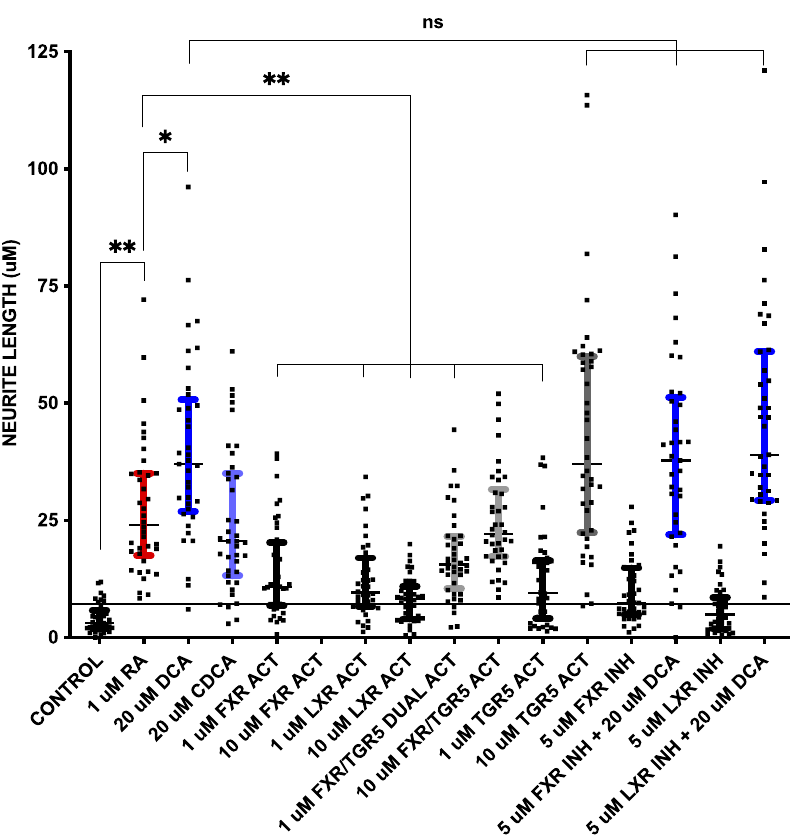
Figure 3. Neurite outgrowth measured as neurite length, as described in Figure 1, from cells in Fig- ure 2. The horizontal line at ~8 μm is drawn through + 1 standard deviation of control neurite length measurements. The conditions in which 1 standard deviation did not overlap with control (i.e., above horizontal line) are colored: 1 μM RA in red, 20 μM DCA in dark blue, 20 μM CDCA in light blue, 1 μM INT 747 (FXR/TGR5 dual activator) in light gray, 10 μM INT 747 (FXR/TGR5 dual acti- vator) in light gray, 10 μM RG-239 (TGR5 activator) in dark gray, 5 μM Z-Guggulsterone (FXR in- hibitor) + 20 μM DCA in dark blue and 5 μM GSK 2033 (LXR inhibitor) + 20 μM DCA in dark blue. * p < 0.01, ** p < 0.001, ns = not significant.